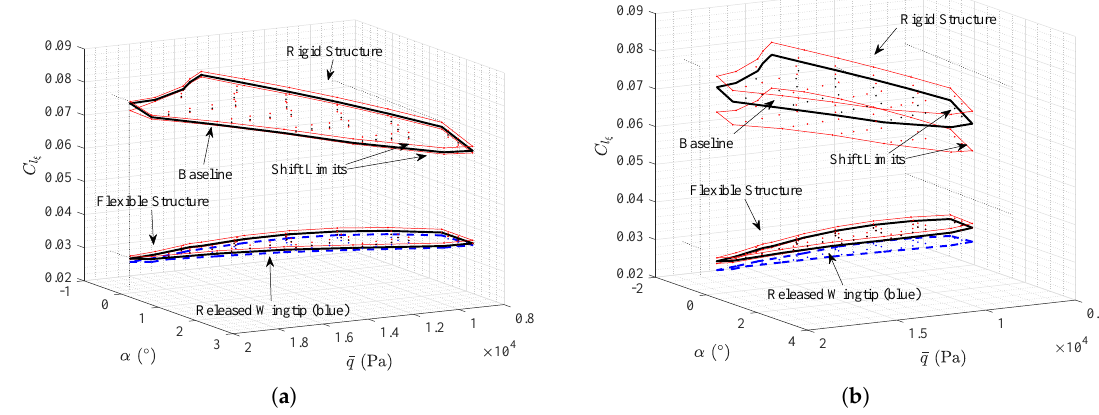
Figure 11. C l variations against ¯ q and α b : ( a ) 2.9 m (10% wing semispan) wingtip device; and ( b ) 5.8 m ξ (20% wing semispan) wingtip